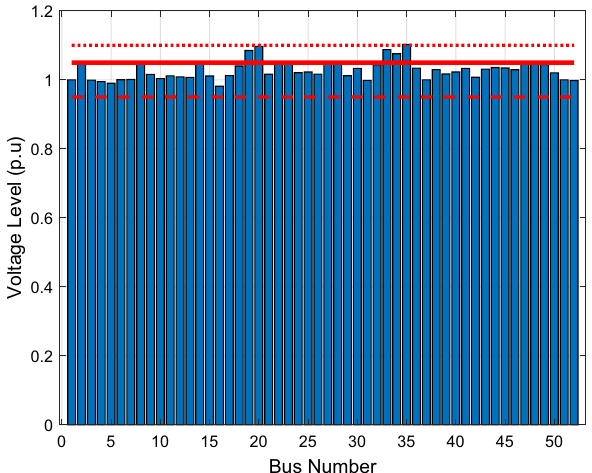
Figure 6. Bus voltage profile of the Nigerian 52-bus system with shunt reactors at five locations.